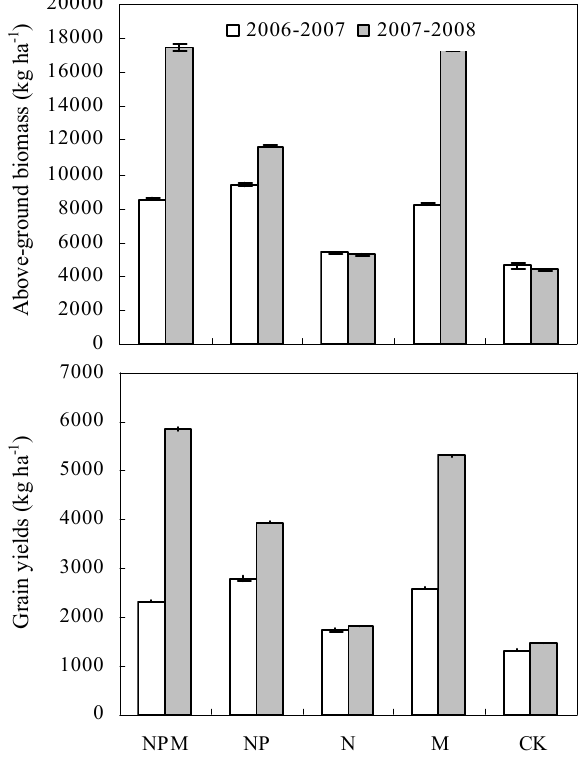
Fig. 4. Above-ground biomass and grain yields of winter wheat for different fertilization treatments from September 2006 until September